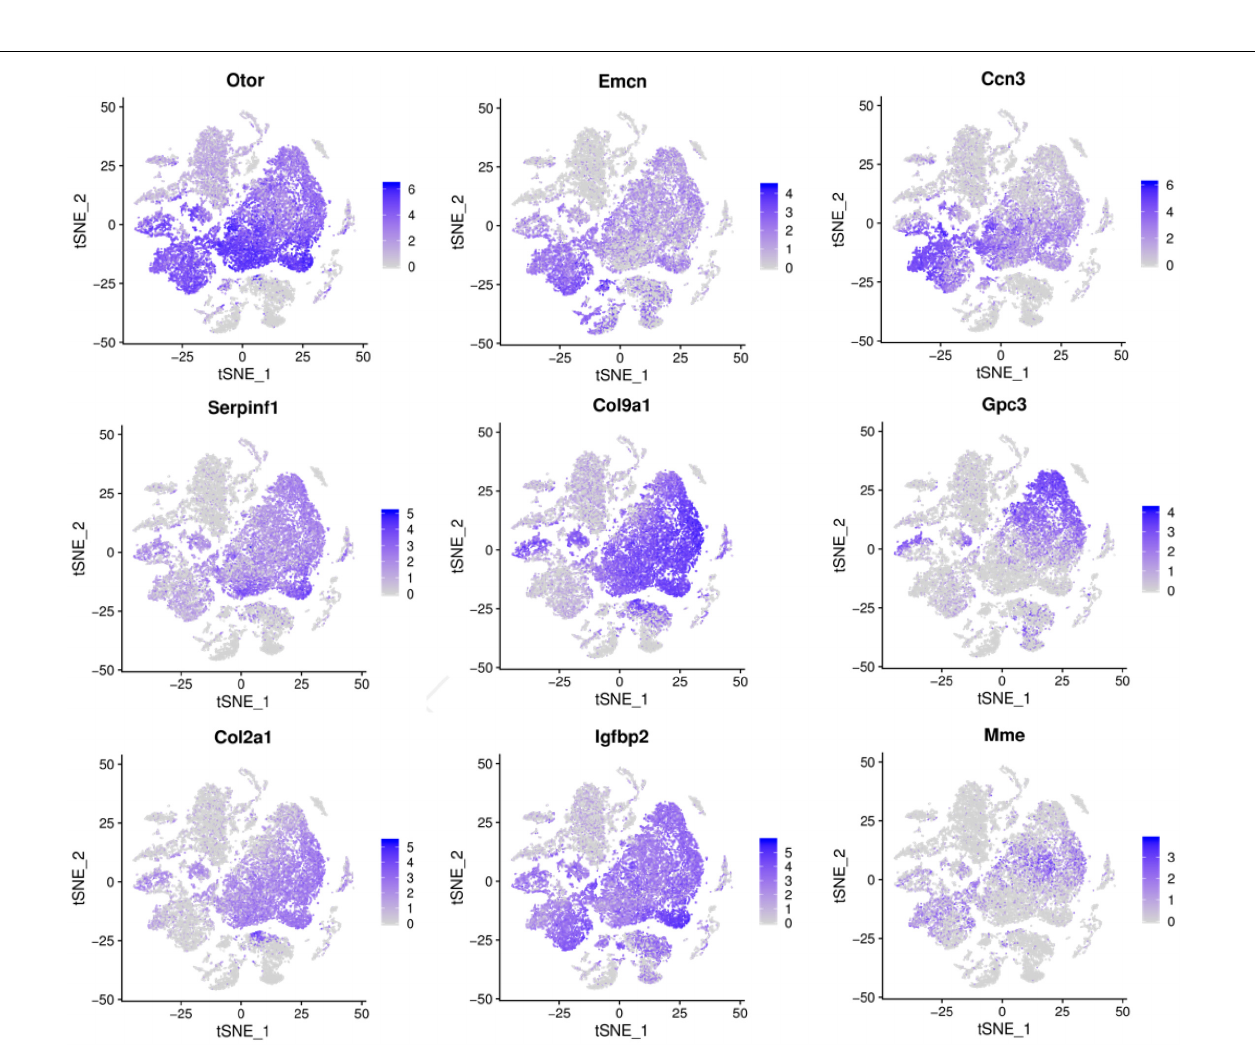
FIGURE 4 | Cells landscape of cochlea duct revealed by scRNA-seq analysis, which was performed on single-cell suspensions pooled from P1, P7, and P14. All samples were analyzed using canonical correlation analysis with the Seurat R package. Cells were clustered using a graph-based shared nearest-neighbor clustering approach plotted by tSNE plot. Feature Plots showing transcript accumulation for specific cell marker genes in individual cells of clusters 0, 2, 3, 4, 6, 7, 9, 12. Color intensity indicates the relative transcript level for the indicated gene in each cell.